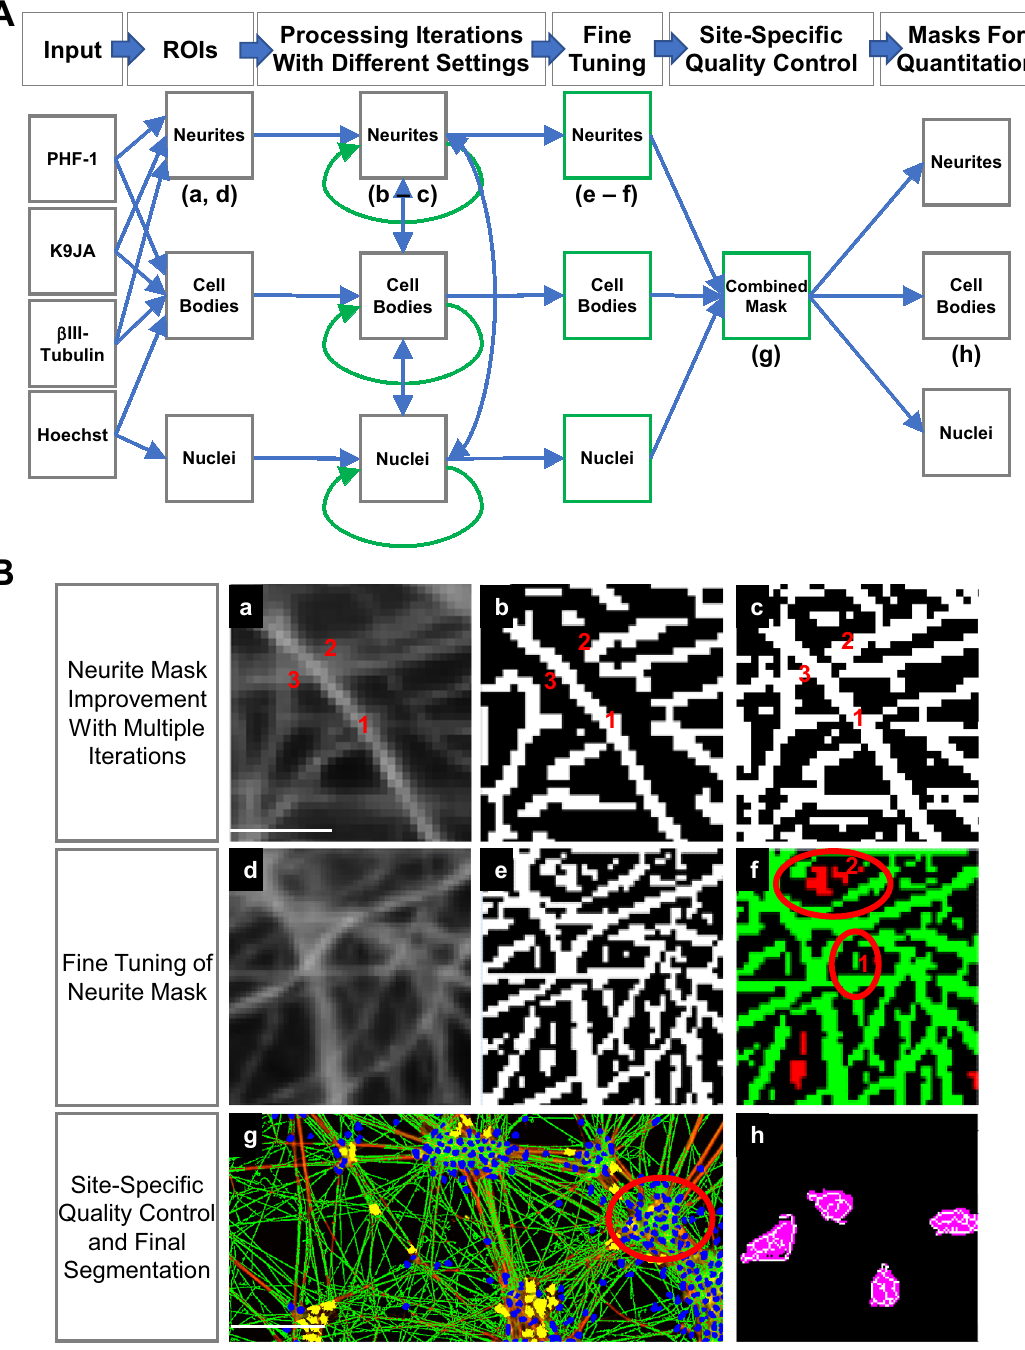
Figure 4. Image segmentation pipeline. ( A ) Schematic diagram of processing steps in the image segmentation pipeline. Information derived from different combinations of imaged channels is used as initial input for segmentation of 3 different subcellular regions of interest (ROI). For segmentation, multiple iterations of a multi-part process are successively used to extract ROI-specific masks; information from each ROI is used to inform identification of the other ROIs; post-iterative extraction, ROIs undergo further fine tuning processes; the combined masks are subject to additional quality control to provide final masks for quantification. Blue arrows indicate information input direction; green arrows/squares indicate processing steps involved, letters reference insets in B. ( B ) Examples highlighting different steps within the image segmentation pipeline. ( a – c ) Comparison of 1st ( b ) vs final iteration ( c ) of neurite mask extraction for input example ( a ) highlighting the advantages of multi-part multi-iteration process: improved segmentation for both major (1) and minor (2) neurites; (3) improved neurite path. ( d – f ) Example of fine tuning for neurite mask. Input ( d ) leads to post-iterative extraction of neurite mask ( e ): neurite segments undergo test to differentiate between true neurite segments (green, 1) and background signal (red, 2). ( g , h ) Final quality control steps. Combined segmentation mask ( g ): neurites (green), neuronal cell bodies (yellow), non-neuronal nuclei (blue). Cell bodies and neurite sections where clumps occur ( g , red circle) are excluded from quantification. Neuronal cell body-derived quantification is restricted to areas NOT crossed by neurites ( h , white lines). Scale bars represent 10 µm for ( a – f , h ). Scale bar represents 100 µm in ( g